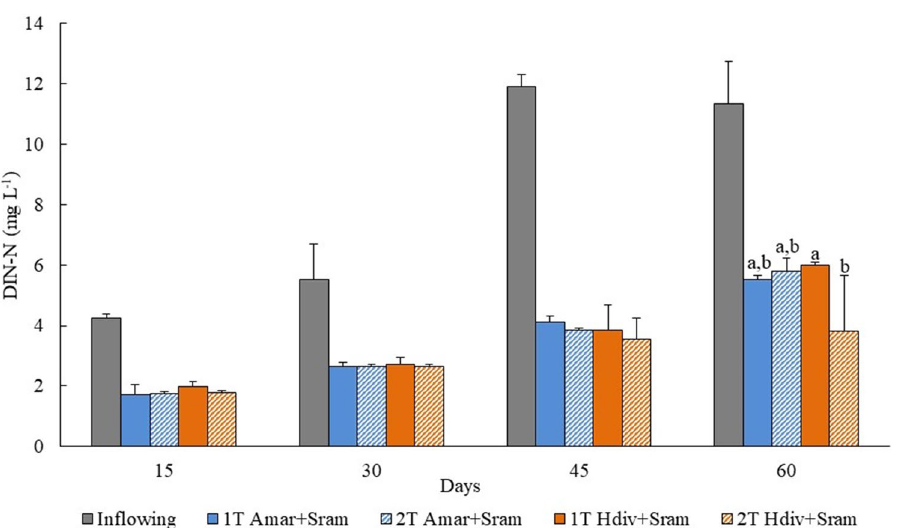
Figure 4. Dissolved inorganic nitrogen (DIN) quantified in the inflowing and outflowing effluent of IMTA designs tested in the present study using as extractive species polychaetes ( Arenicola marina —Amar—and Hediste diversicolor —Hdiv) and halophytes ( Salicornia ramosissima —Sram) cultured in the same tank (1 T) or in two separate tanks (2 T). Average values ± SD (n = 5). Statistical analysis performed only for the period of 120 days when biomass was evaluated. Different letters indicate significant differences ( p < 0.05) between IMTA